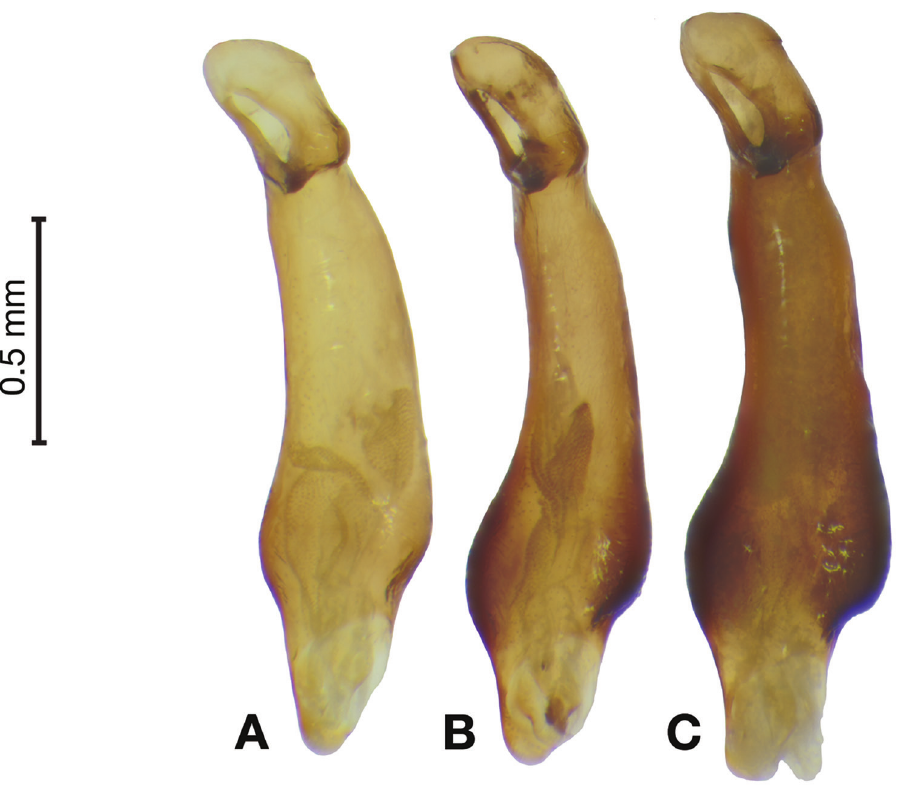
Figure 19. Digital images showing intrapopulation variation of form and scleritization of male phallus of Brachichila hypocrita Chaudoir, ventral aspect. A lightly sclerotized with slight swelling towards apex B mod- erately sclerotized with moderate swelling towards apex C heavily sclerotized with widely expanded